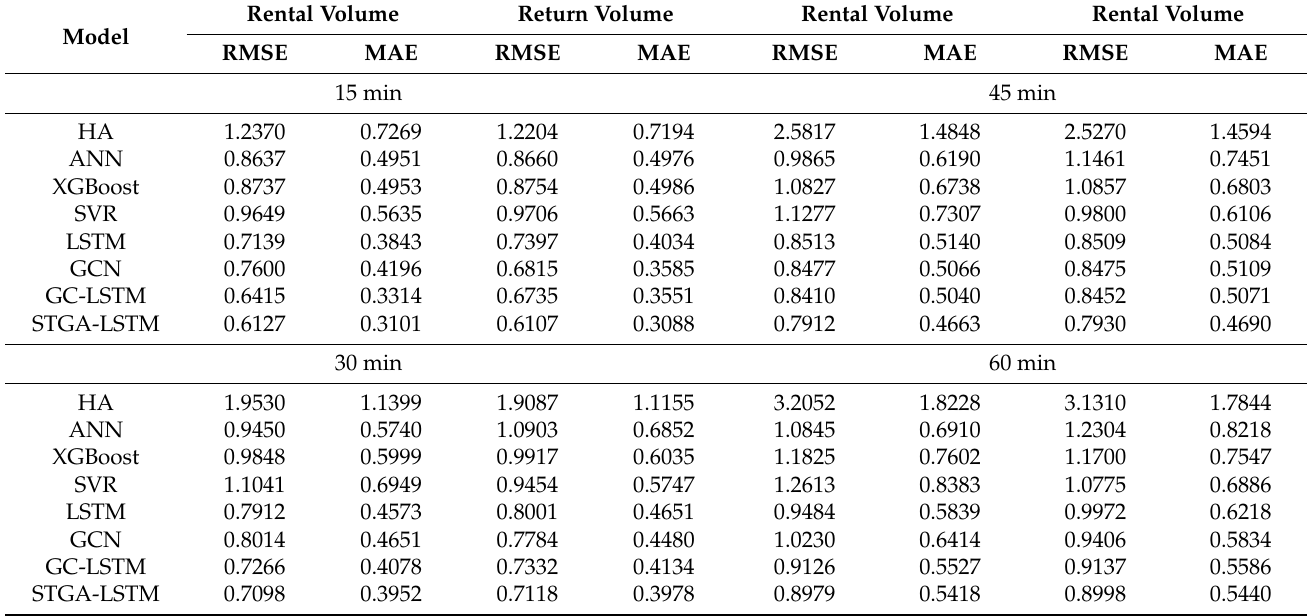
Table 1. Predictive performance of different models on the test